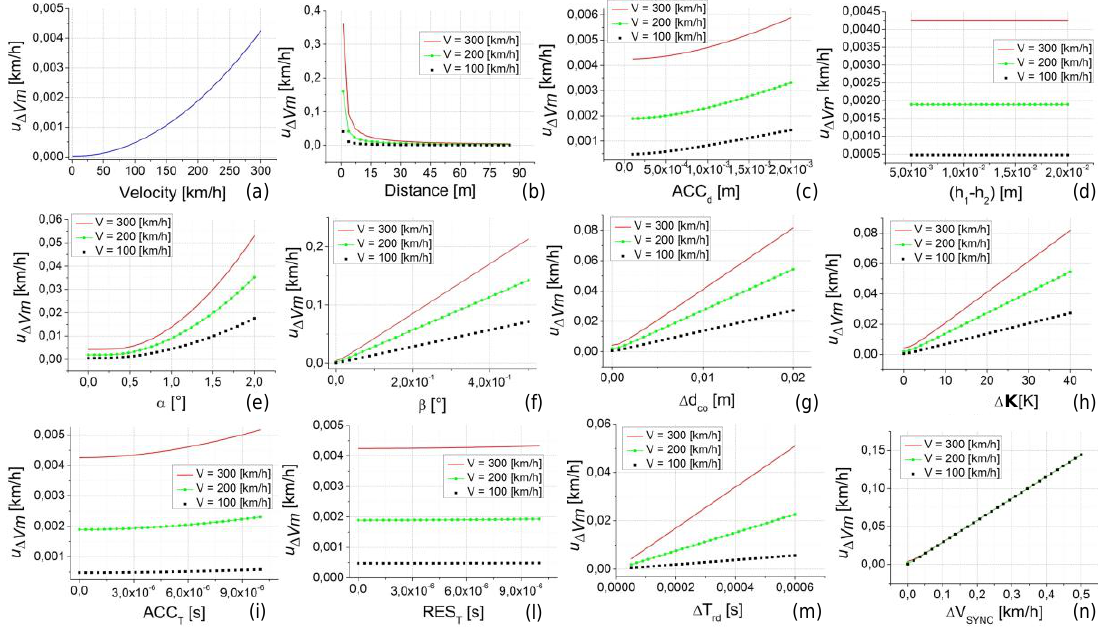
Figure 9. Uncertainty of the calibration method ( 𝑢 ∆𝑉 ) versus the uncertainty contribution parameters. In each plot from ( a – n ) the independent variable is one parameter. The plots are relative to case study 2 (d = 85 m, speed = 100, 200, and 300 km / h, all the other parameters set to their minimum value, as reported in Table 2).